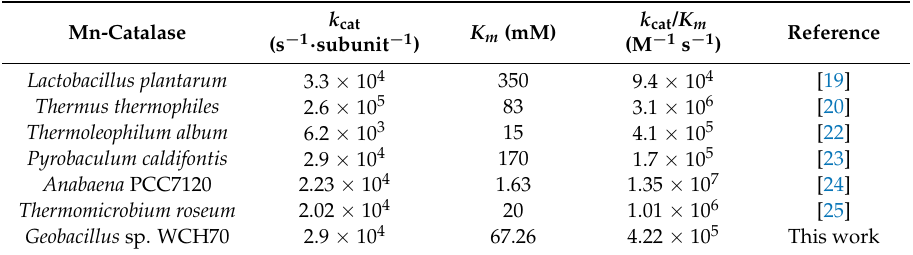
Table 2. The kinetic parameters of GWC compared with those of other characterized